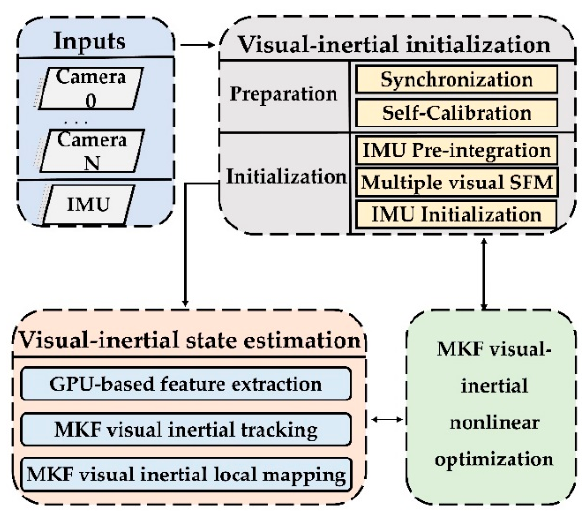
Figure 1. The framework of the proposed VINS-MKF.